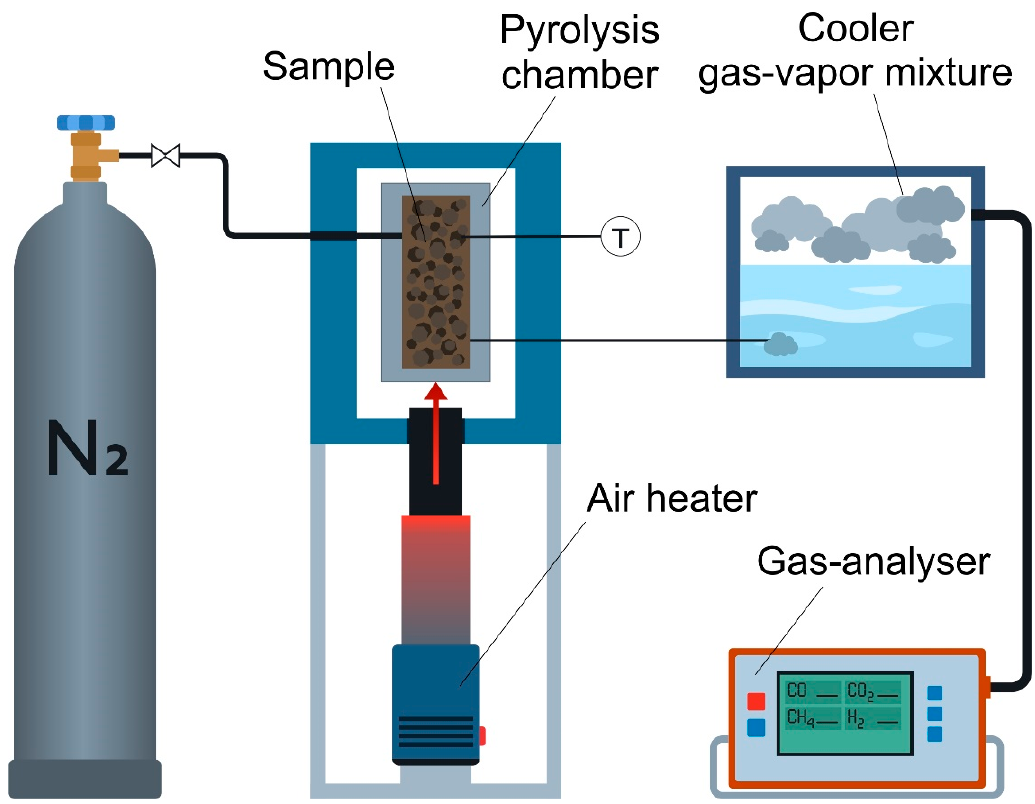
Figure 1. Schematic diagram of the experimental setup for pyrolysis of nut shell biomass. A 30 g sample of the fractioned nut shell was placed into a cylindrical reactor, with 145 mL (height—115 mm, diameter—40 mm) operating in a batch mode. About 70–80% of the reactor volume was filled depending on the bulk density of the nut shell samples.